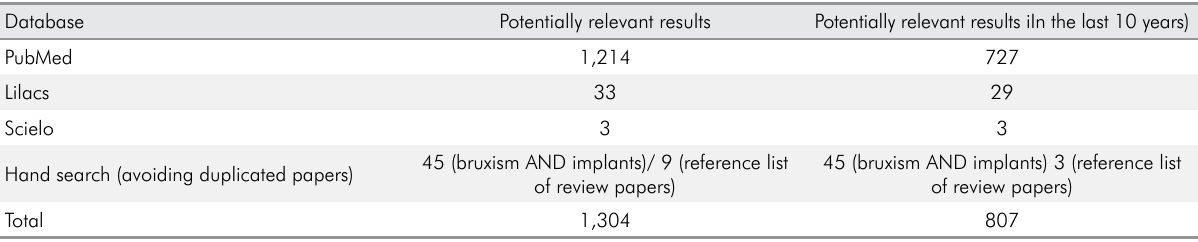
Table 1. Potentially relevant titles from the four database searches.